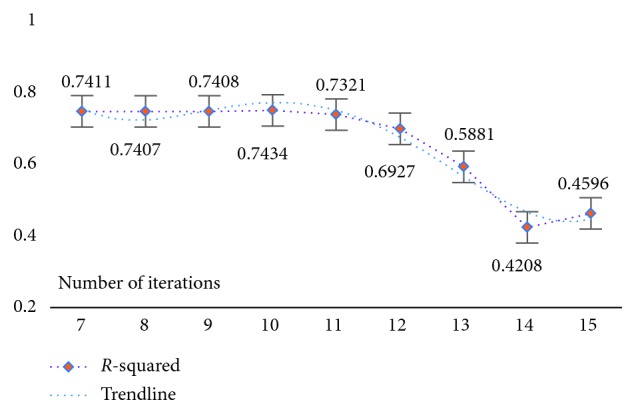
WYHXB: R-squared.